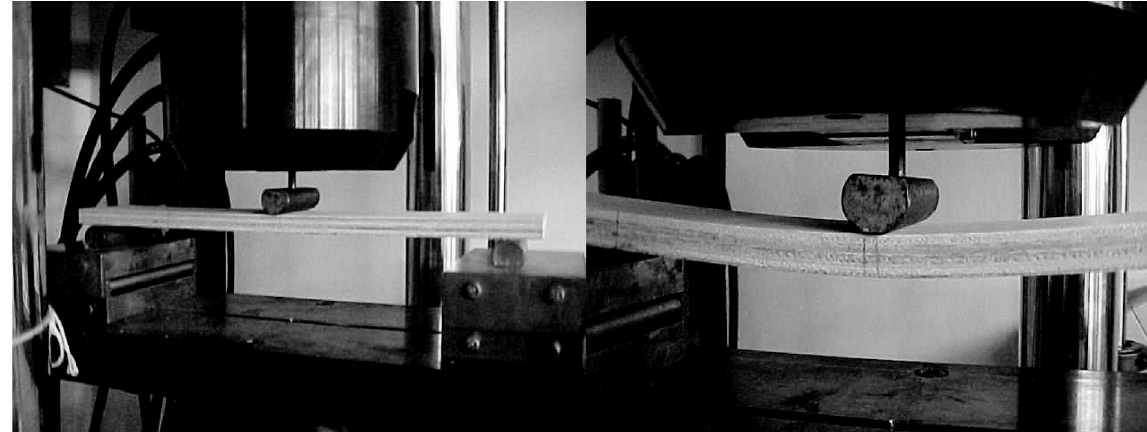
Figure 2. Mechanical test for determination of static bending properties.